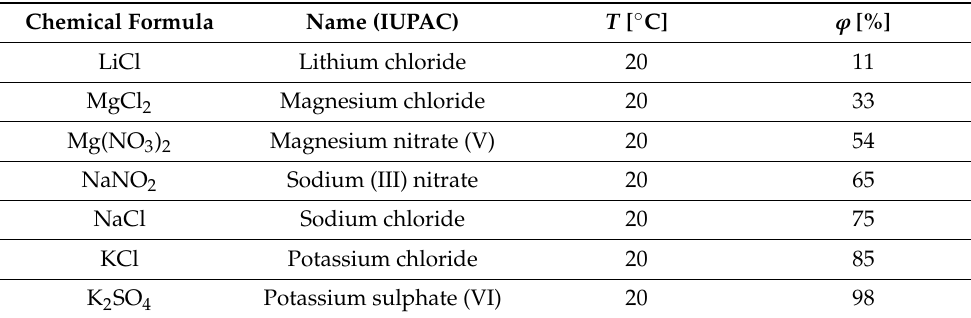
Table 2. The steady-state values of relative humidity over saturated aqueous solutions of selected salts, based on